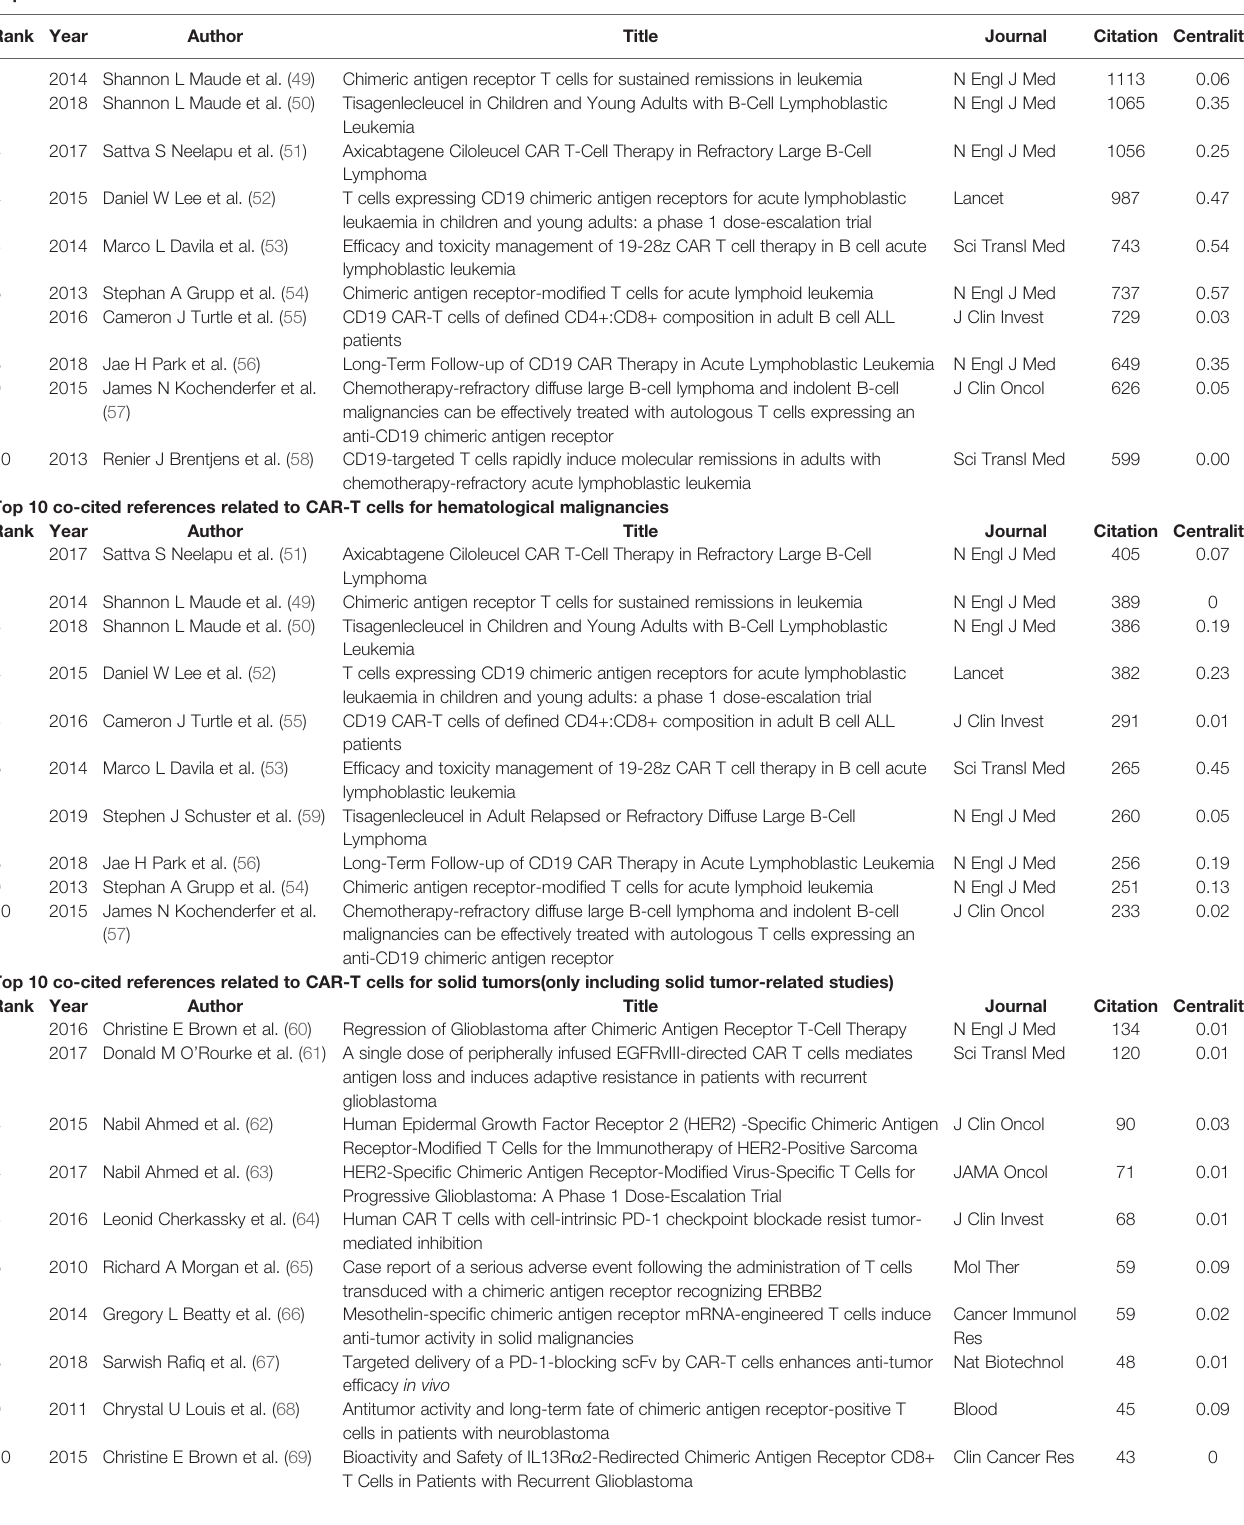
TABLE 5 | The top 10 co-cited references related to the CAR-T cell fi eld. Top 10 co-cited references related to CAR-T